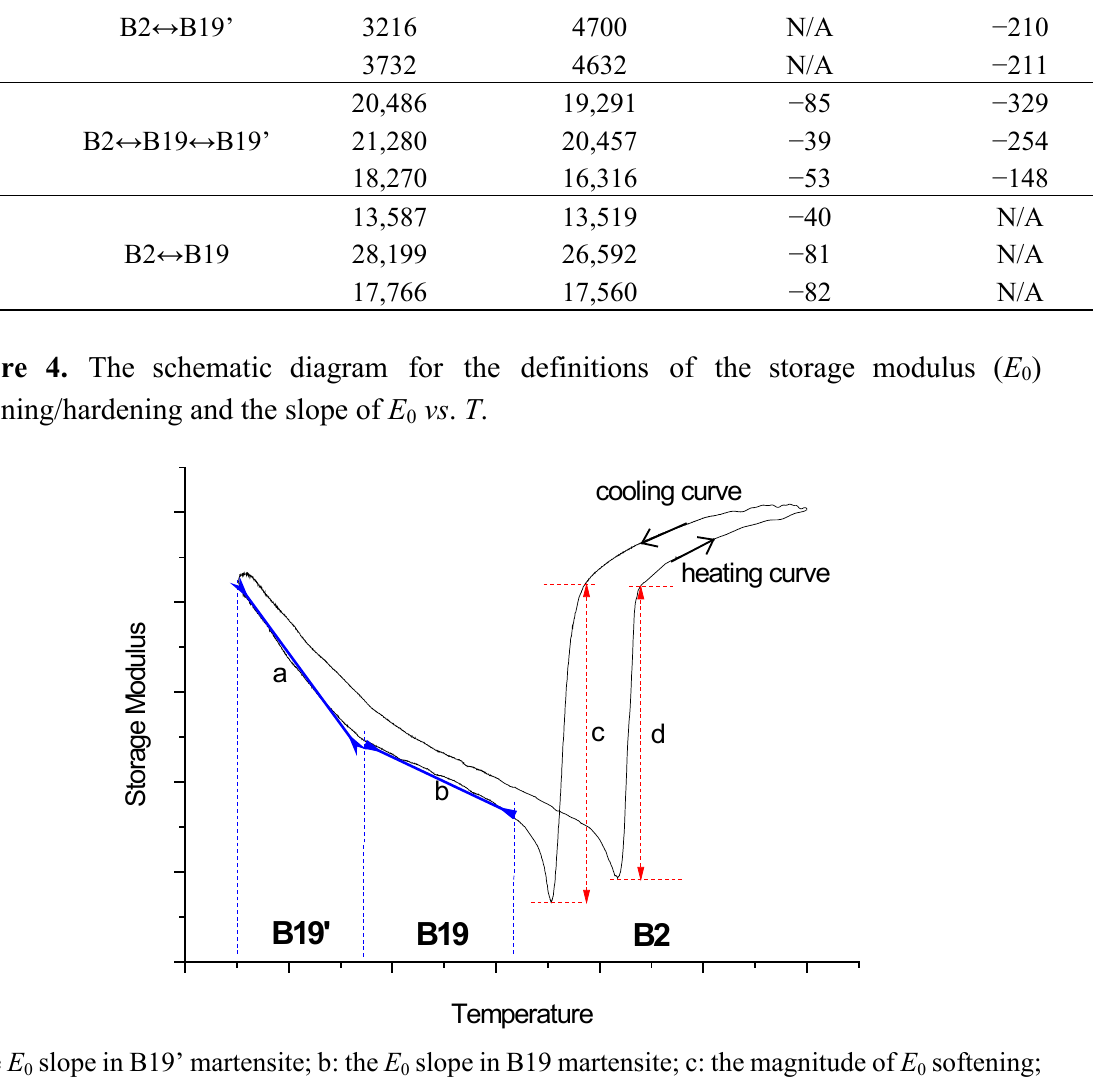
Table 1. Summary of the storage modulus ( E curves in B19 and B19’ martensites which are defined in the Figure 4.